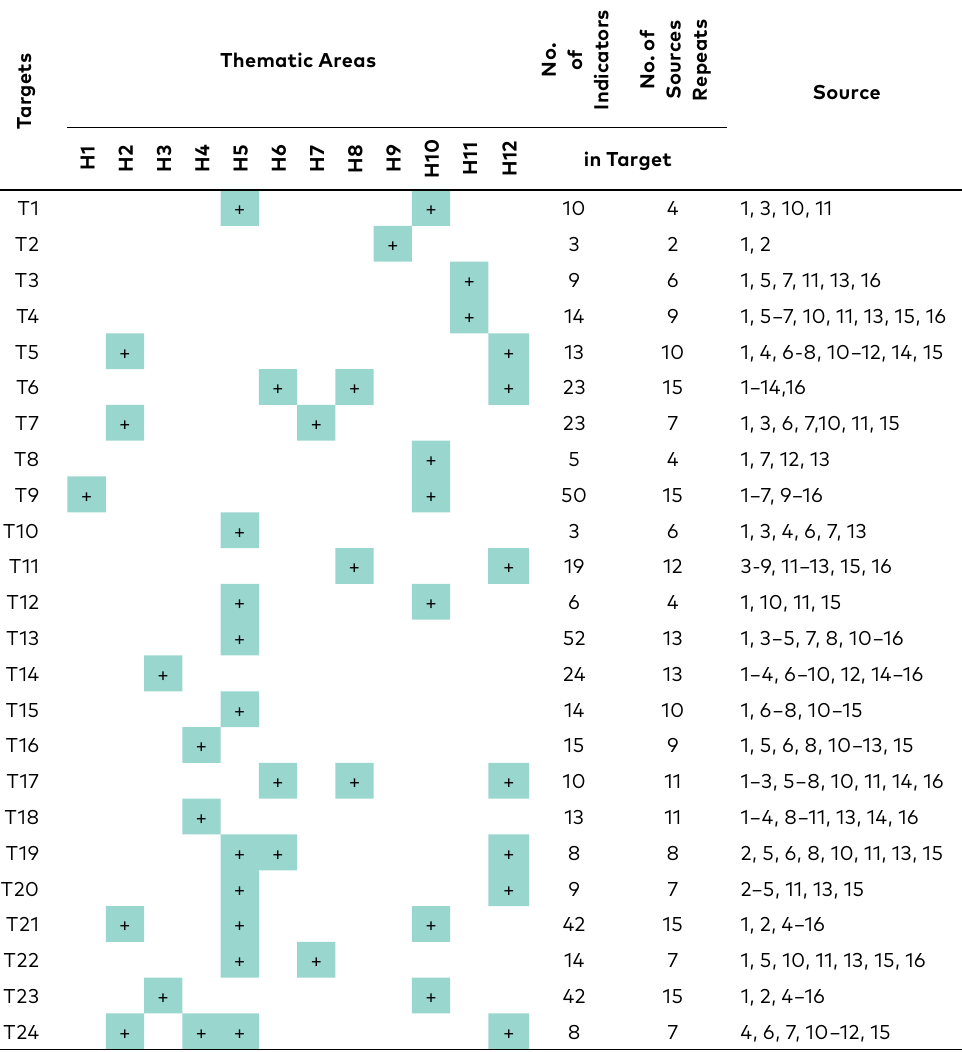
Table 4. The classification of thematic areas and